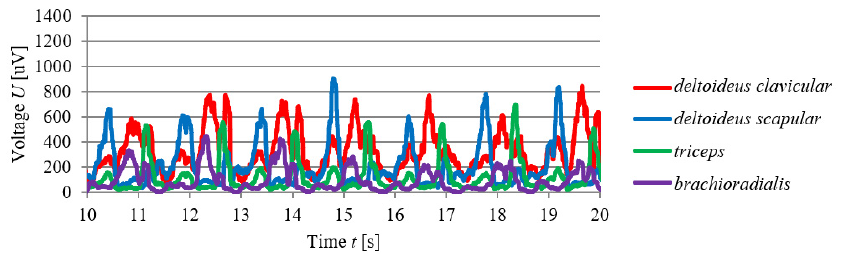
Figure 7. EMG chart for the right upper limb muscles for the Wheelchair Push-rim Drive (WPD). Figure 8 presents the monitored human muscles.